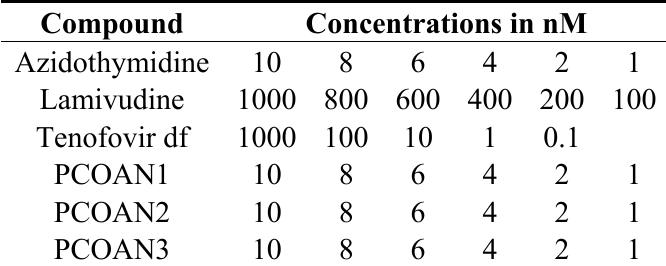
Table 1. Compounds and concentrations.